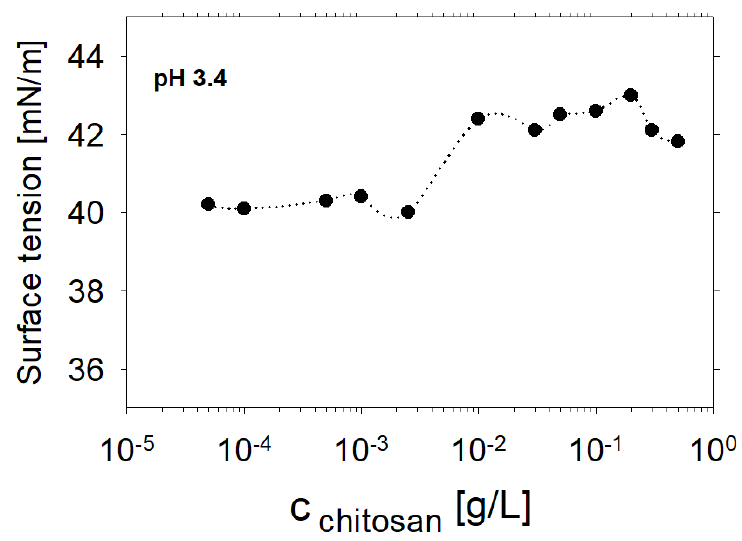
Figure 5. Equilibrium surface tensions of saponin solutions and saponin–chitosan mixtures in the presence of 0.1%wt. acetic acid for pH 3.4 that were measured after 3 h (>10,800 s) of adsorption. The saponin concentration was fixed to 0.1 g/L while we varied the chitosan from 0.0005 to 0.3 g/L.